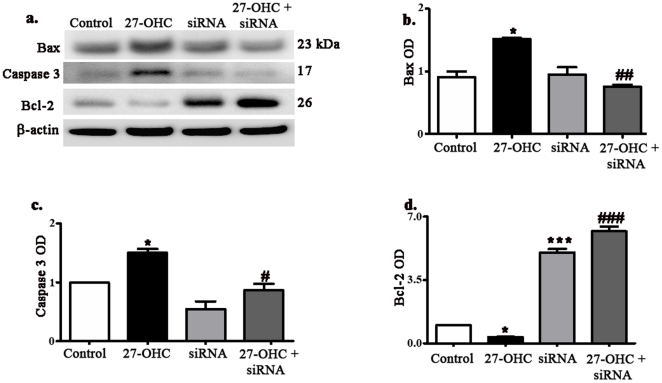
siRNA to gadd153 gene reverses 27-OHC-induced apoptosis.Treatment of slices with 27-OHC while increases levels of the pro-apoptotic Bax and of the active caspase 3, this treatment reduces levels of the anti-apoptotic Bcl-2 (a–d). siRNA to gadd153 reduces the increase in Bax as well as caspase 3 levels and markedly increases levels of Bcl-2 in presence or absence of 27-OHC. *p<0.05 and ***p<0.001 versus controls; #p<0.05, ##p<0.01 and ###p<0.001 versus 27-OHC.